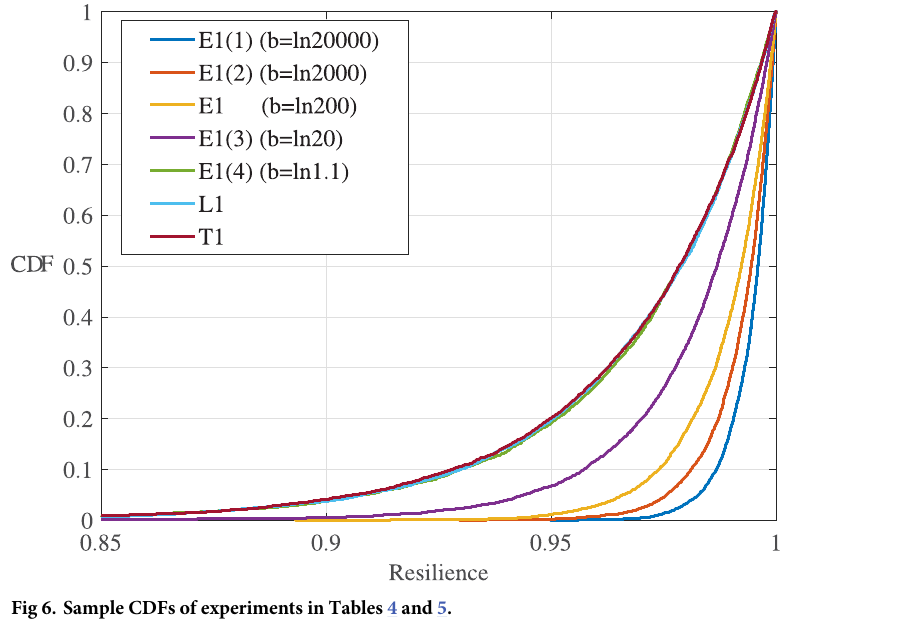
Fig 6. Sample CDFs of experiments in Tables 4 and 5.